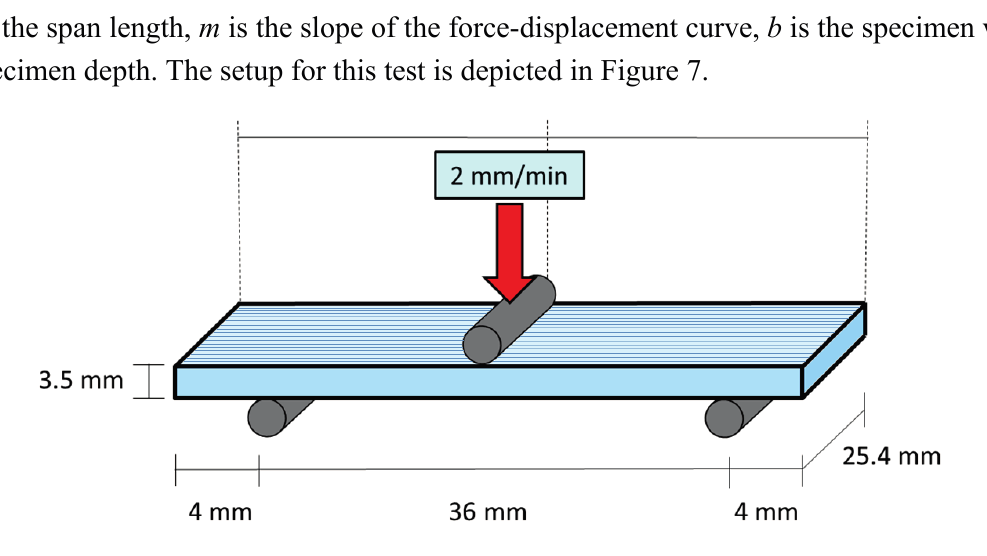
Figure 7. The specimen geometry used for the bending test of unidirectional